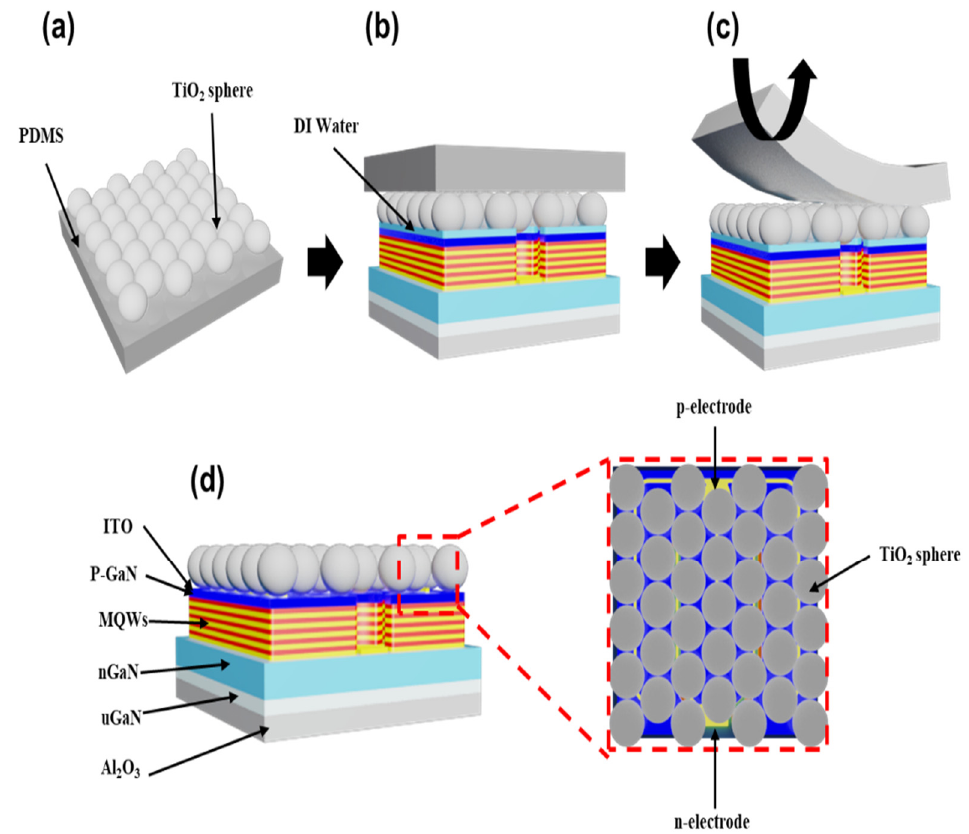
Figure 1. Process flow from formation of TiO 2 monolayer to its transfer on LED chips. ( a ) Formation of TiO 2 NSs ML on a PDMS, ( b ) drop-casting of DI water and flip of TiO 2 /PDMS pad, ( c ) removing of PDMS from TiO 2 NSs ML, ( d ) formation of arrays of TiO 2 NSs ML on LED chips.